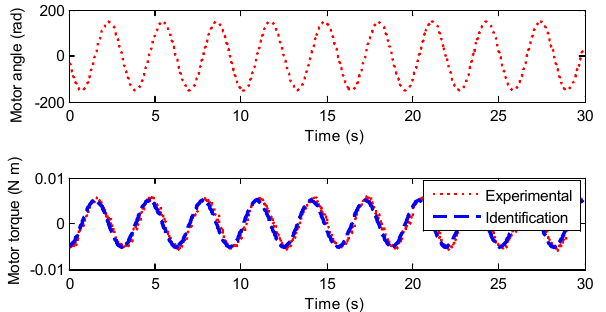
Figure 14. The identification experimental result of motor viscous damping.